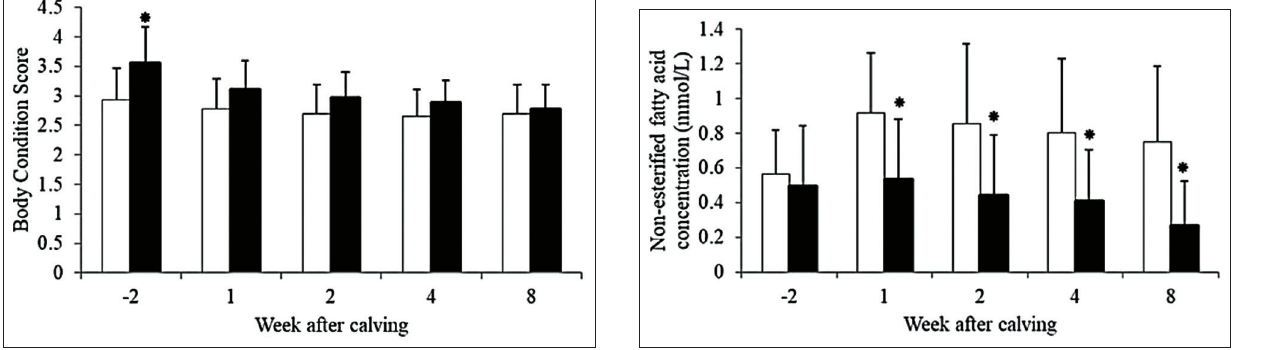
Figure-2: Dynamics of body condition score at 2 weeks Figure-4: Dynamics of serum non-esterified fatty acid before expect calving date at 2 weeks before parturition concentration at 2 weeks before expect calving date and 1, and 1, 2, 4, and 8 weeks after parturition of smallholder 2, 4, and 8 weeks after parturition of smallholder (□, n=15) (□, n=15) and semi-commercial ( , n=17), error bars and semi-commercial ( , n=17), error bars stand for stand for standard deviation. standard ■ ■